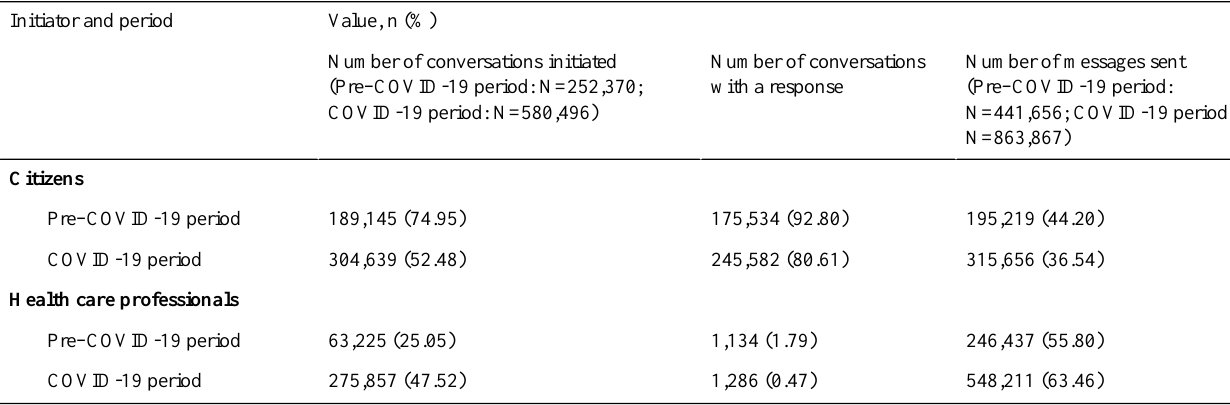
Table 3. Activity by initiator (health care professional or citizen).